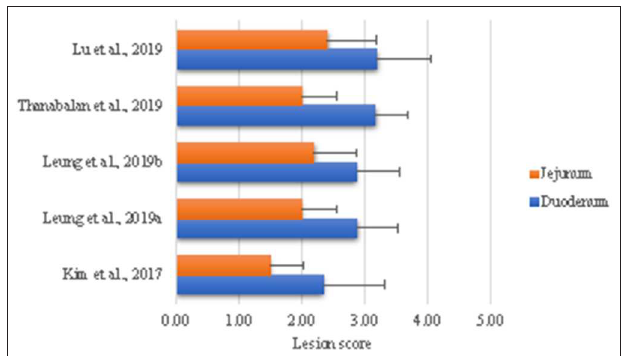
FIGURE 1 | Intestinal lesion scores in broiler chicks challenged with Eimeria . All birds were challenged with 100,000 E. acervullina and 60,000 E. maxima sporulated oocysts on day 10 of age with exception of Kim et al. (84) in which case birds were challenged on day 5. Birds were necropsied 5 days post-challenge to assess lesion scores as described by Price et al. (90) using a scale of 0 (none) to 4 [high; Johnson and Reid